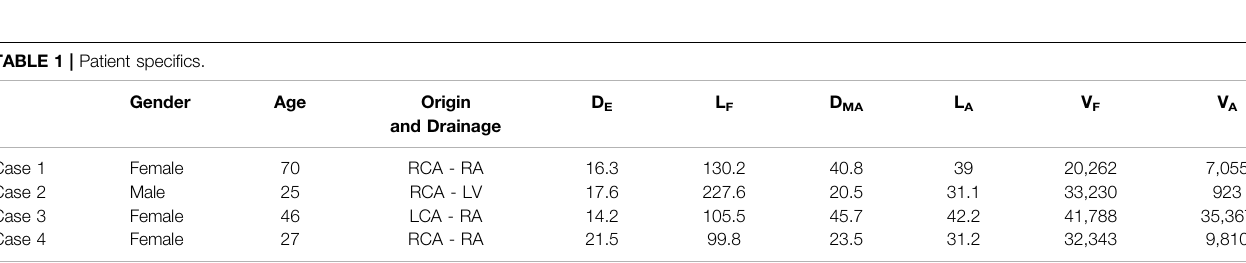
TABLE 1 | Patient speci fi